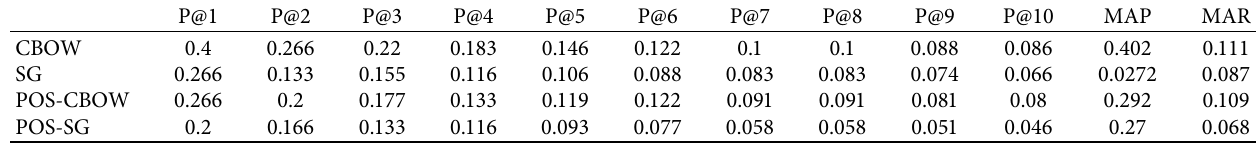
Table 11: Best results of synonym extraction from KSUCCA POS-tagged.